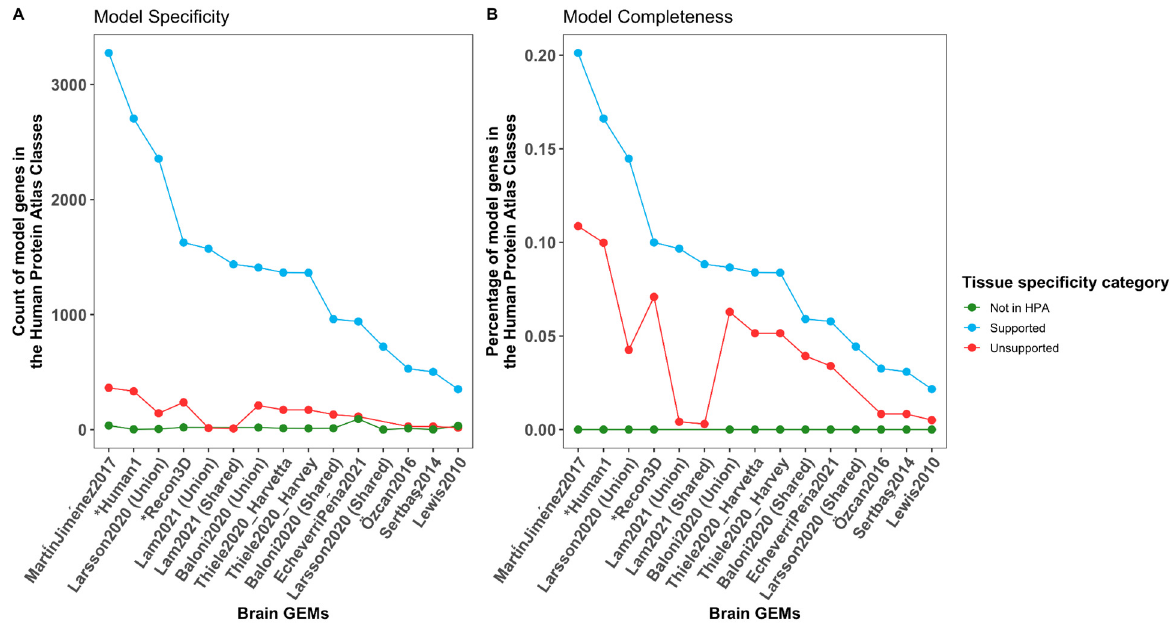
Figure 2. Completeness of the human brain metabolic reconstructions is linked to less specificity according to the Human Protein Atlas brain-specific category. ( A ) The genes of the brain reconstructions in addition to the Recon3D model and Human1 were classified into five categories based on differential tissue expression of the brain. These five categories were grouped into supported (in blue) and unsupported (in red). Model genes outside the HPA coding genes were coloured in blue. ( B ) Since the total number of genes in each category differs, completeness was computed as the ratio of model genes in a category and the total number of genes in that category. The number and completeness of supported and unsupported genes are higher in MartínJiménez2017 than in Human1, which indicates the loss of brain specificity by increasing the completeness of the model. Generic models are highlighted with “*”.